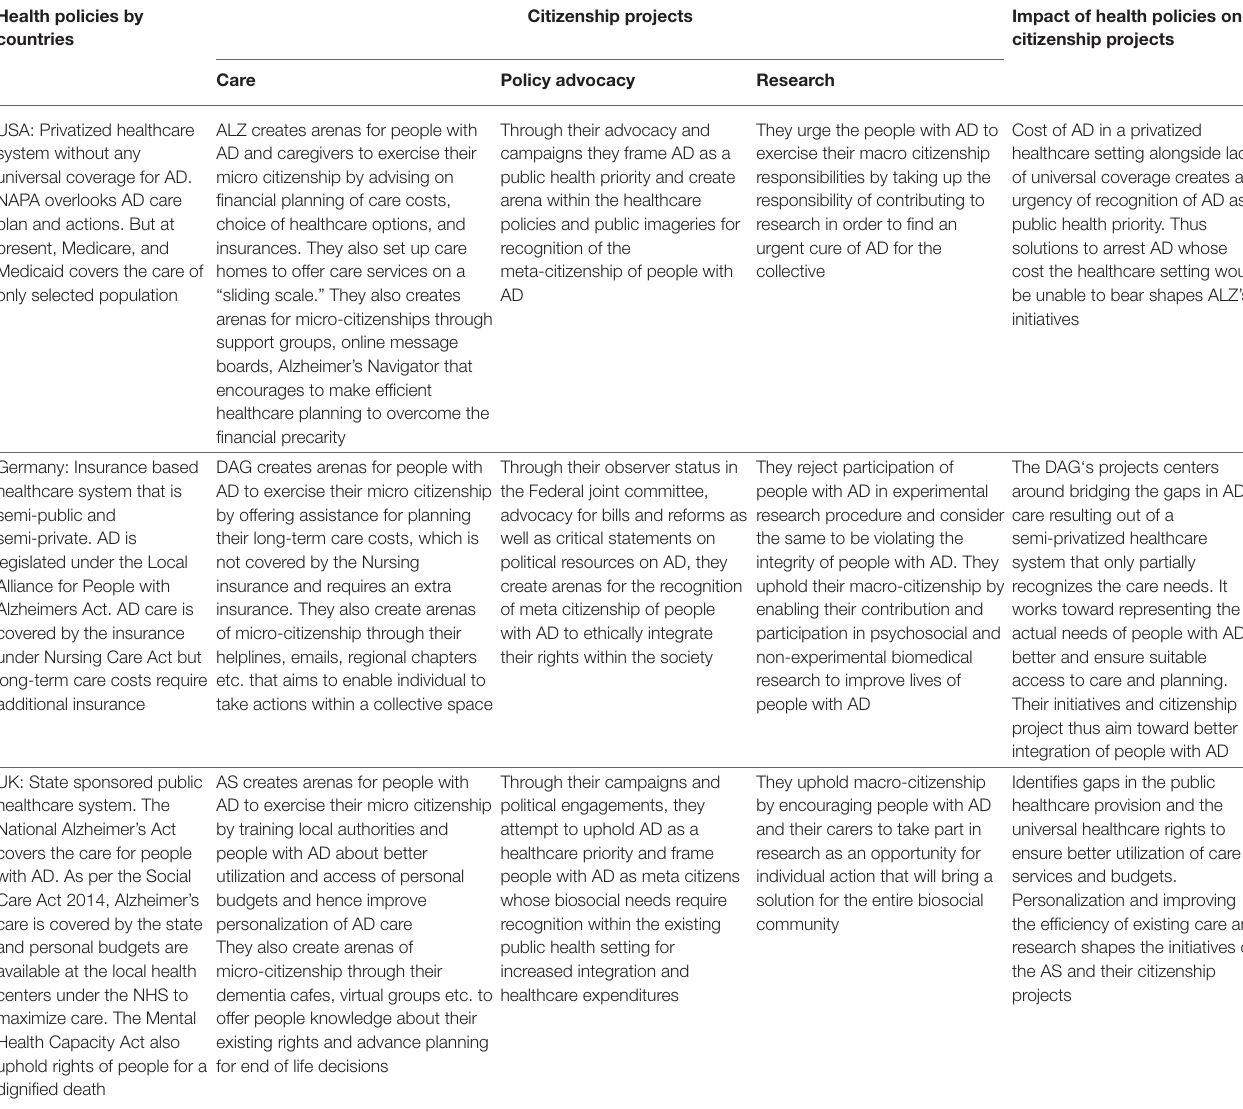
TABLE 2 | Comparing the impact of different healthcare systems in shaping PO’s citizenship